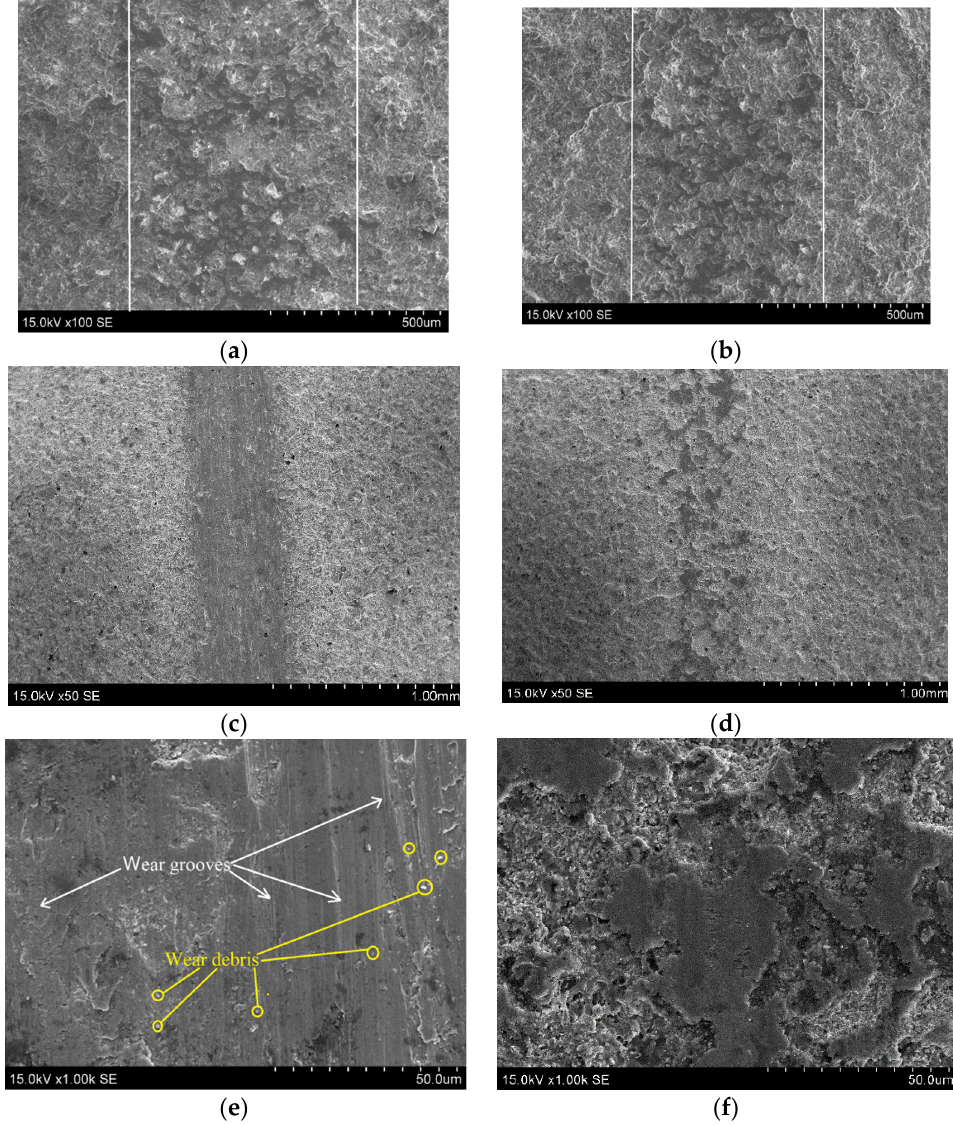
Figure 7. Wear scars images of ( a , b ) Al 2 O 3 and ( c – f ) Al 2 O 3 -ZrO 2 coatings deposited at ( a , c , e ) 180 A and ( b , d , f ) 220